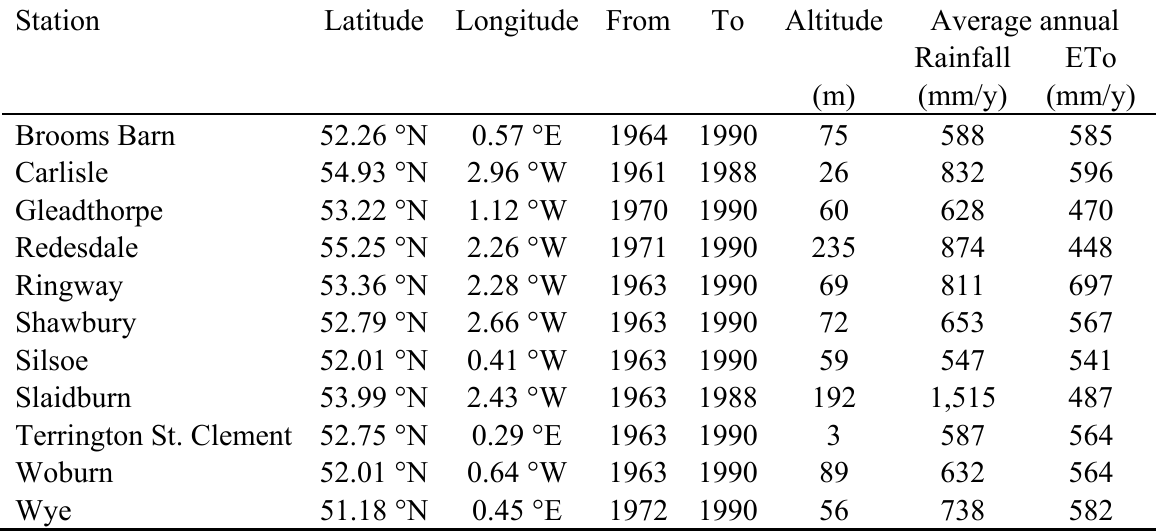
Table 1. Location, altitude, data range and average annual rainfall and reference evapotranspiration (ETo) for the 11 meteorological stations.